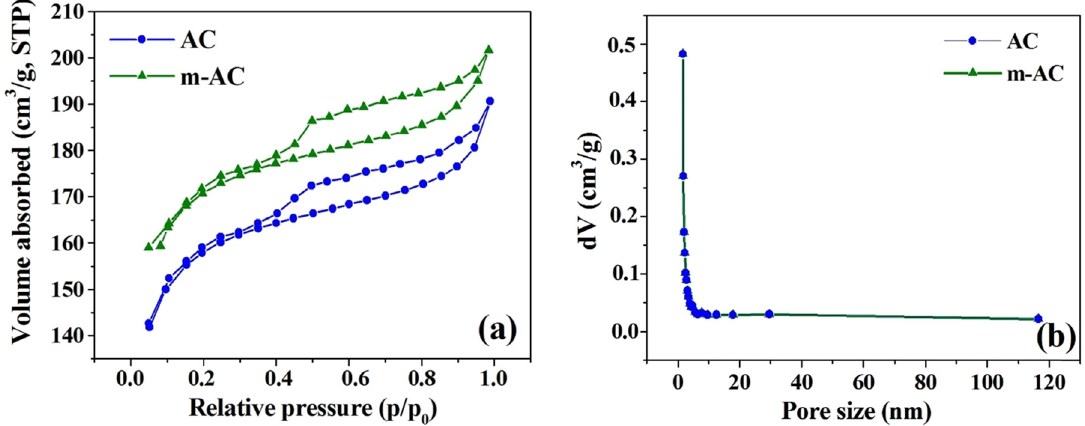
Figure A4: ( a ) Nitrogen adsorption – desorption isotherms and ( b ) pore size distribution of AC and mAC.